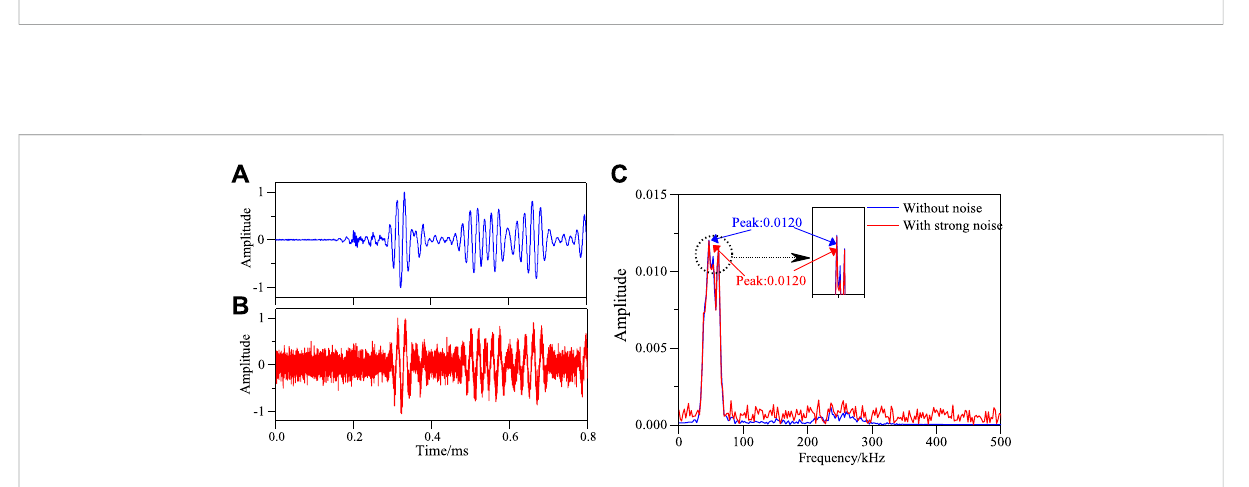
FIGURE 20 Frequency spectrum of S5 – S9 sensing channel without damage in structure under strong noise environment. (A) Effective signal-undamaged. (B) After adding 3 dB with noise. (C) Frequency spectrum of S5 – S9 signal sensing